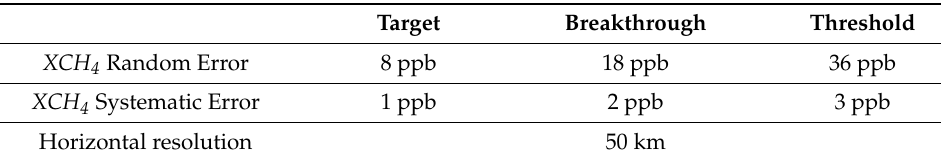
Table 2. User requirements for MERLIN.